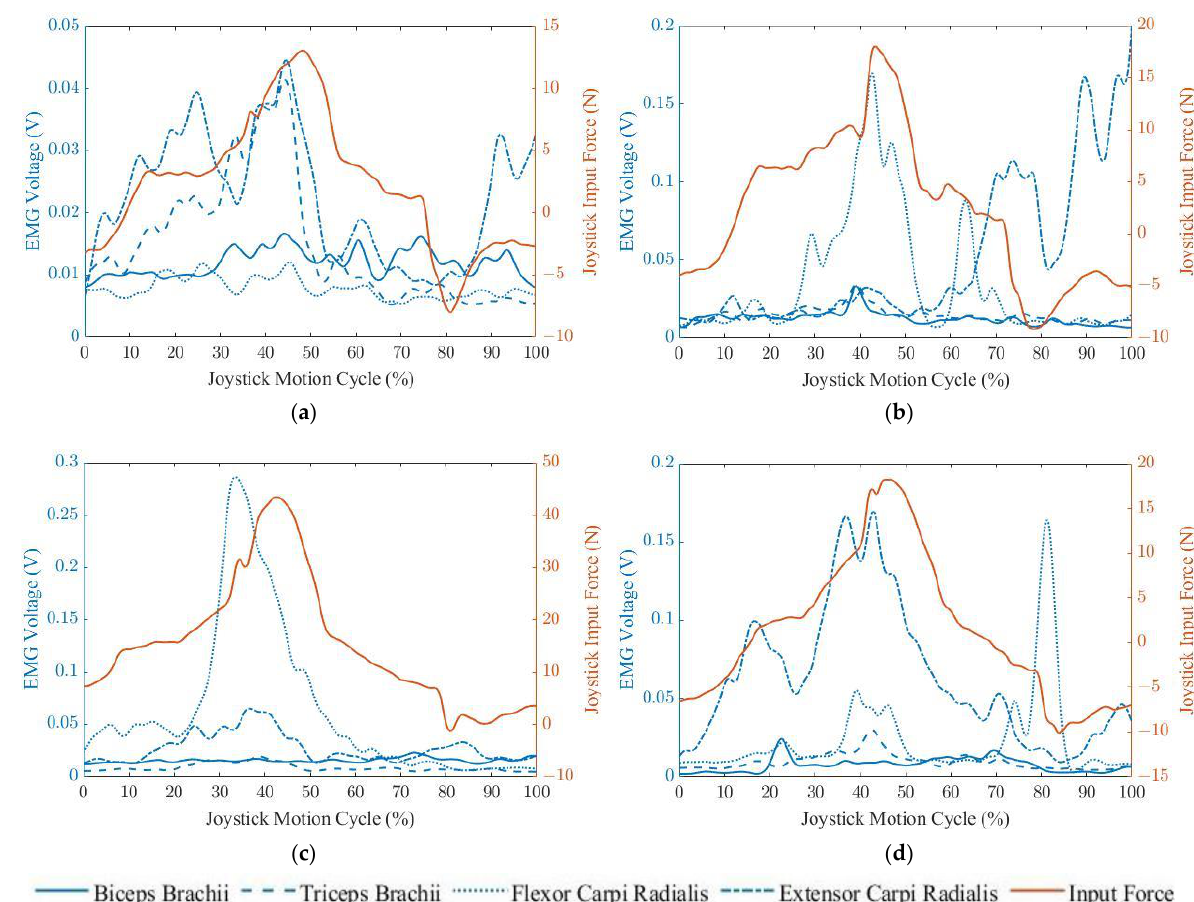
Figure 5. Representative example of muscle activation in the arms, measured by EMG (V) and joystick input force (N) during a representative (1) participant’s fore ( a ), aft ( b ), inward ( c ), and outward ( d ) joystick throws while using the dynamic armrest.